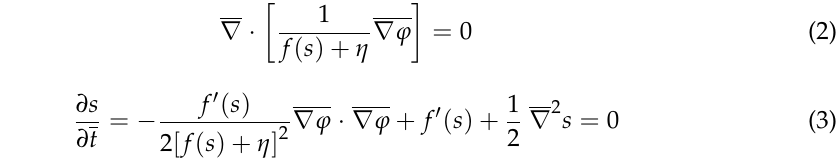
Figure 4. Energy storage performance of TiO 2 /PI nanocomposite. ( a ) Schematic setup for the measurement of breakdown strength. ( b ) Breakdown strength and ( c ) Energy storage density of the TiO 2 /PI nanocomposites with 1, 2, and 5 wt% loading and pure PI at various temperatures. ( d ) Comparison of the energy storage density of the PI-based composites at RT and high temperature [13,35–41]. Based on the structural characterization of TiO 2 nanoparticles and the thickness of the TiO 2 /PI nanocomposite, a two-dimensional model was designed for finite element analysis. The relative permittivity of PI was set to 3.5, the ratio of the relative dielectric permittivity of the inner and outer parts of the nonsolid TiO 2 nanoparticles was set to 1:100, and the permittivity of the solid TiO 2 nanoparticles was set to 100. For linear dielectrics, we normalized the control equation for better numerical simulation. The variables and analytic functions in the model are set according to the following two equations. The dimensionless form of which can be written as